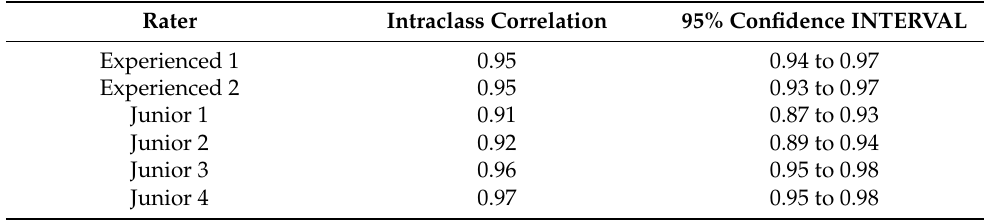
Table 1. Intra-rater agreement of the Forrest classification.